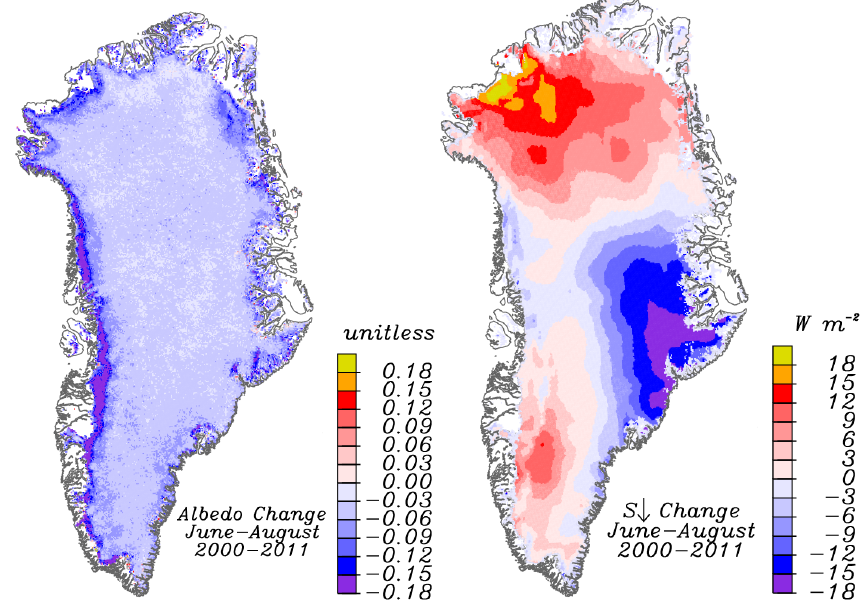
Fig. 7. (a) Summer (June–August) spatial patterns MODIS MOD10A1 5km albedo temporal change 2000–2011 derived from the linear regression. (b) Summer change in MAR downward shortwave simulations calibrated using GC-Net AWS data.